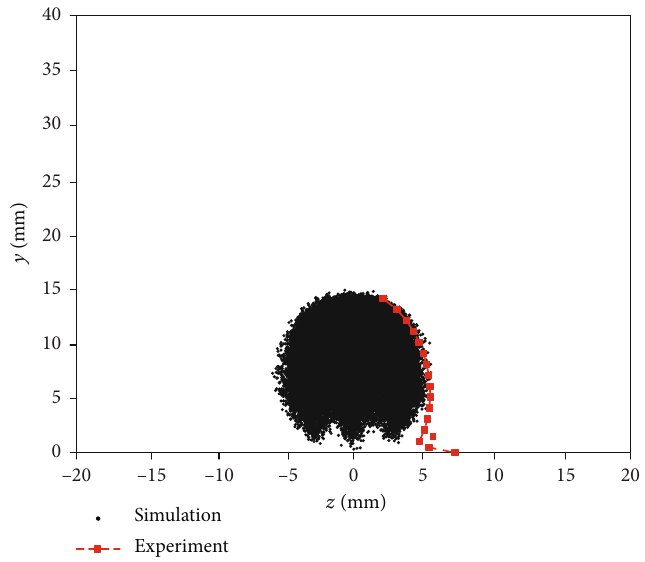
Figure 10: Model veri fi cation in spray cross-sectional spread.